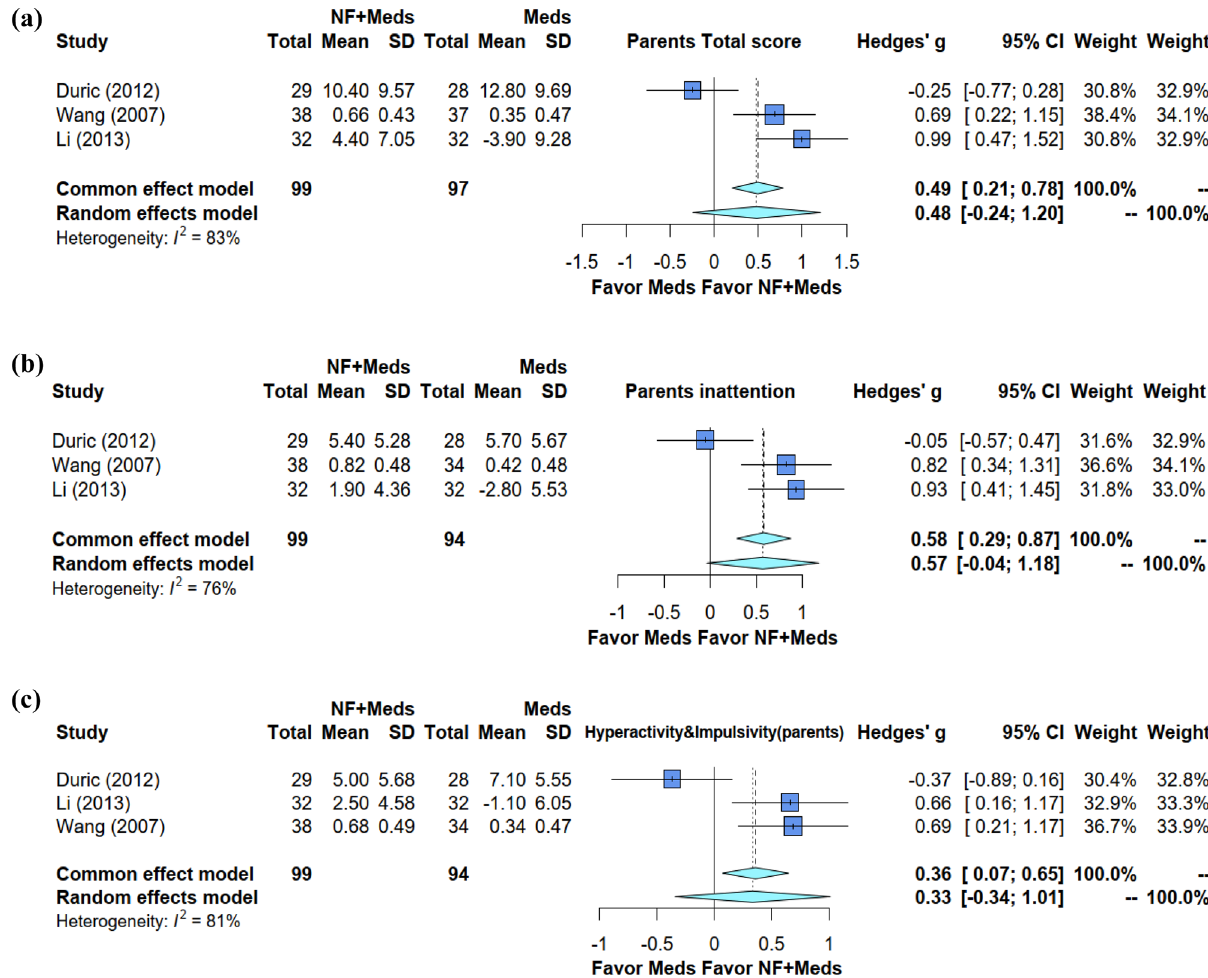
Figure 4. Forest plot of effect sizes for comparing the difference between combined treatment and medication alone groups 6 months after NF intervention ( a ) in the improvement of global symptoms ( b ) inattention, and ( c )